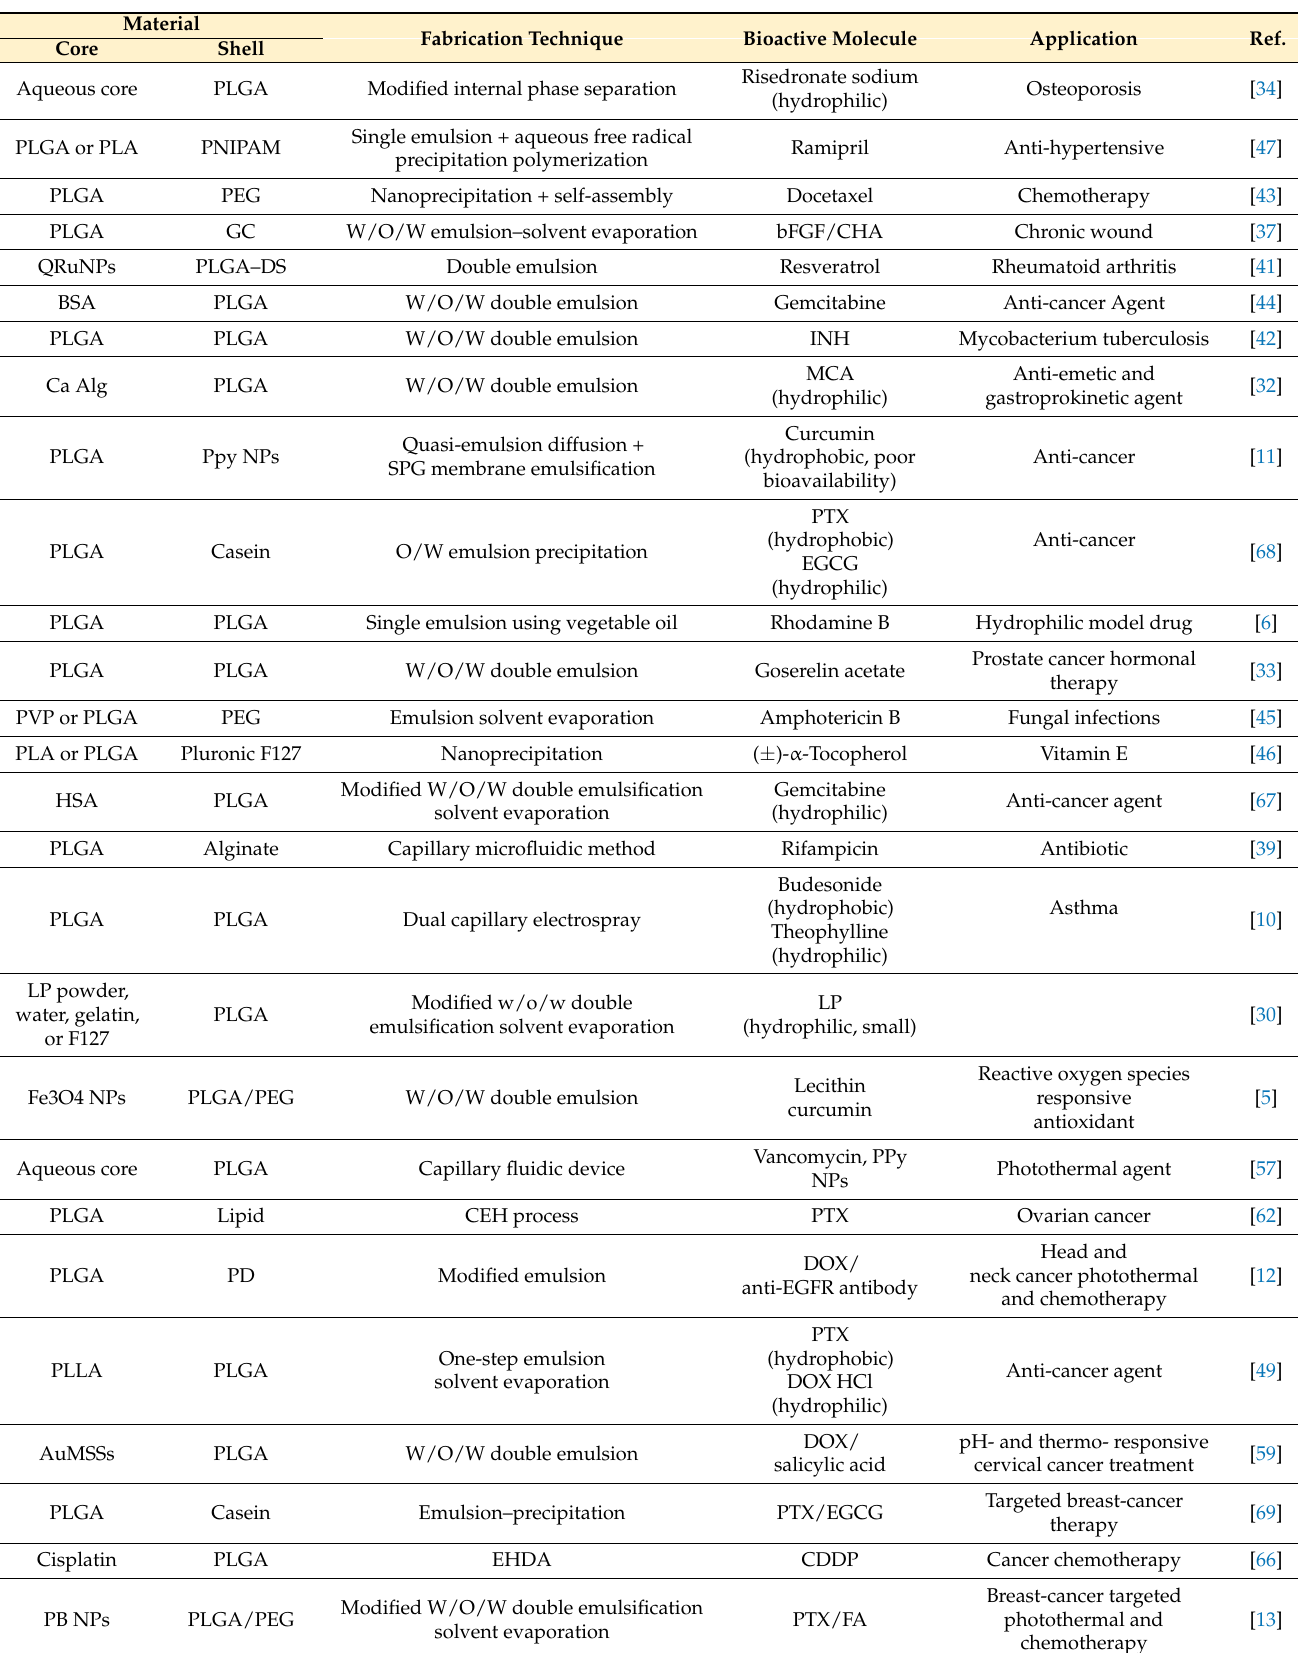
Table 1. Summarizes the PLGA core–shell micro/nano particles for various biomedical